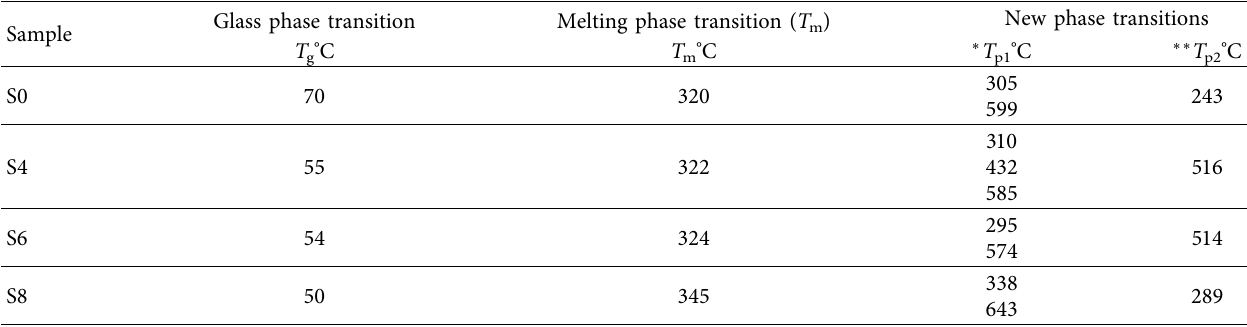
Table 1: Transition temperatures for CuONPs-doped HEC